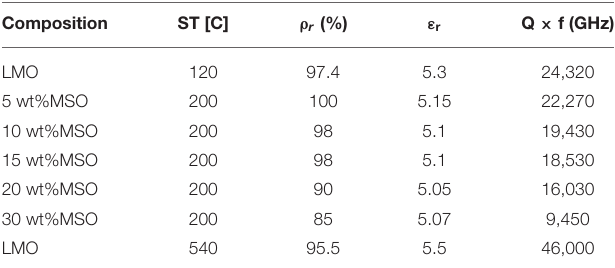
TABLE 1 | Sintering temperatures, densities, and microwave dielectric properties of LMO-xMSO composite